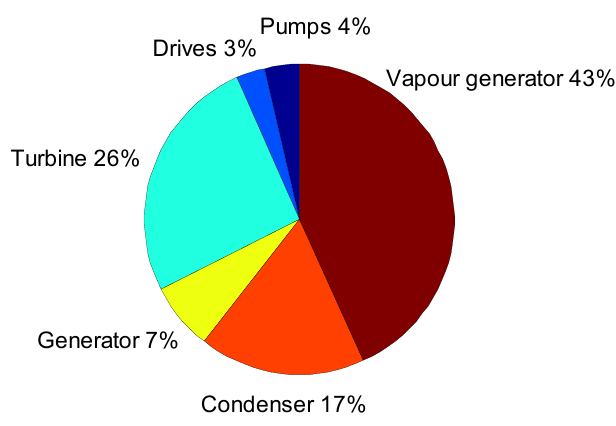
Figure 14. Distribution of the cost at minimum SIC for the SCORC.